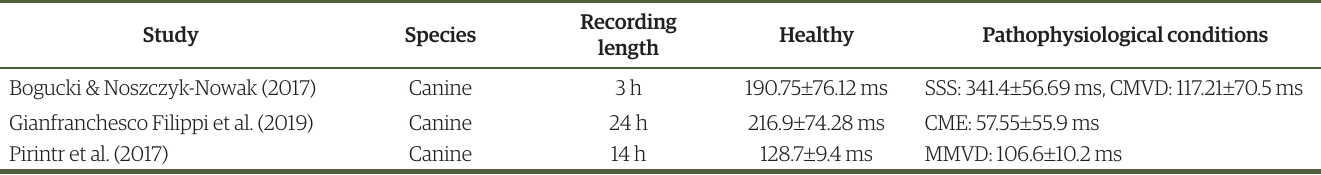
Table 3. Summary results of selected studies from the literature, depicting the recording length for data acquisition and the SDNNidx values for healthy animals or those presenting pathophysiological conditions.